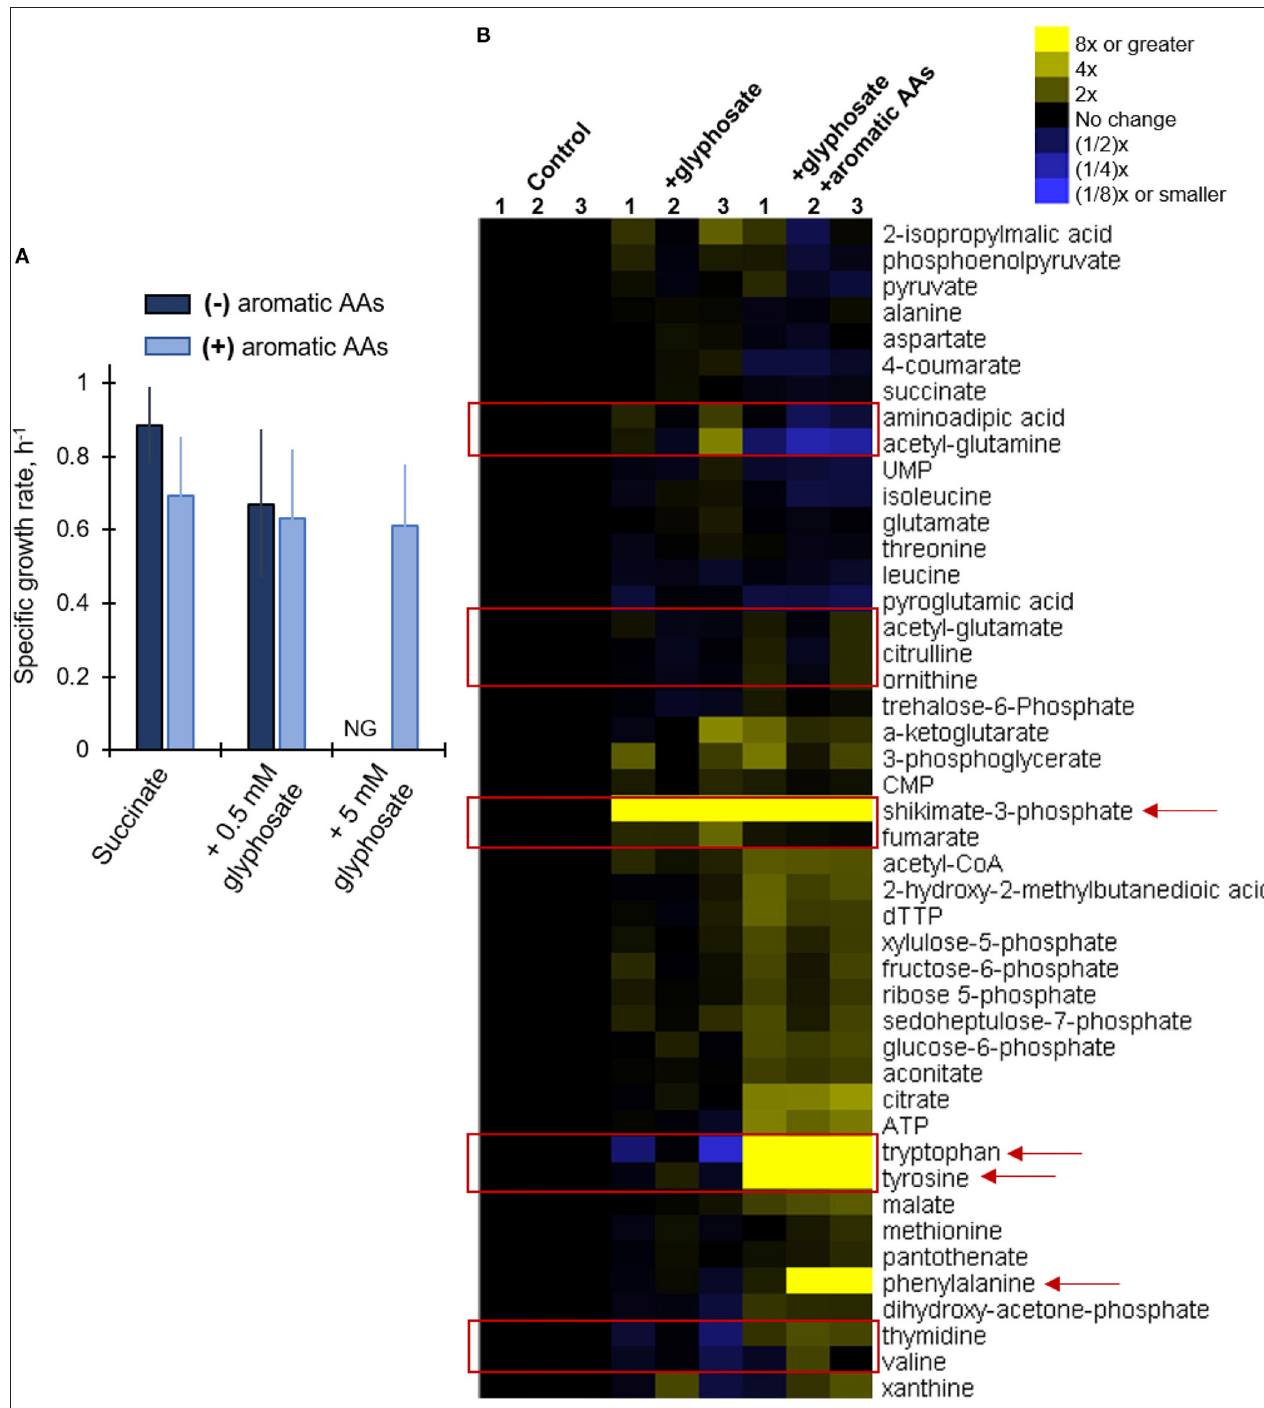
FIGURE 6 | Growth and metabolic phenotypes of glyphosate-exposed P. putida S12 to supplementation of aromatic amino acids in the growth media. (A) Growth rates (average ± standard deviation) of succinate-grown and glyphosate-exposed cells without (dark blue) and with (light blue) added aromatic amino acids (AAs) in the growth medium); see materials and methods for more details. (B) Unsupervised hierarchical clustering of metabolite levels in succinate-grown cells in the absence (control), presence of 0.5 mM glyphosate ( + glyphosate) or the lethal glyphosate dose, 5mM, and aromatic AAs ( + glyphosate + aromatic AAs). Columns 1, 2, and 3 represent data from independent biological replicates. The red rectangular boxes highlight metabolite levels in the metabolome that were disrupted in the presence of glyphosate. The red arrows indicate metabolites that are present in the shikimate pathway. Abbreviation for (A) : NG, no growth. The measured data in (A) were from three biological replicates ( n =